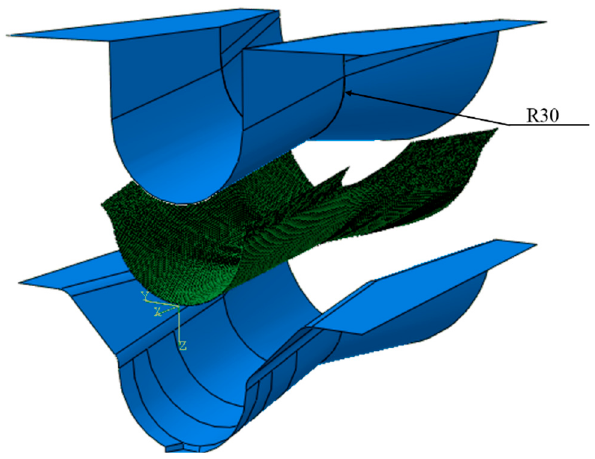
Table 1. Finite Element Method (FEM) simulation parameters of material.